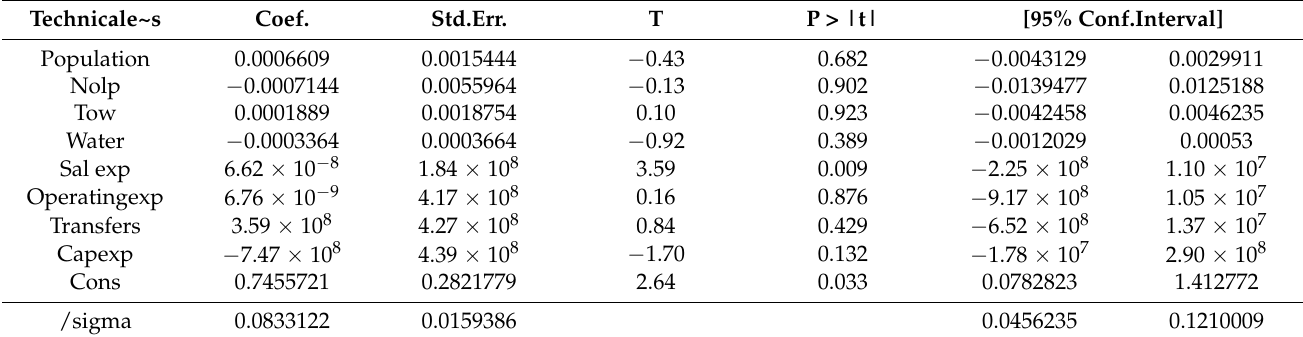
Table 13. Tobit Results